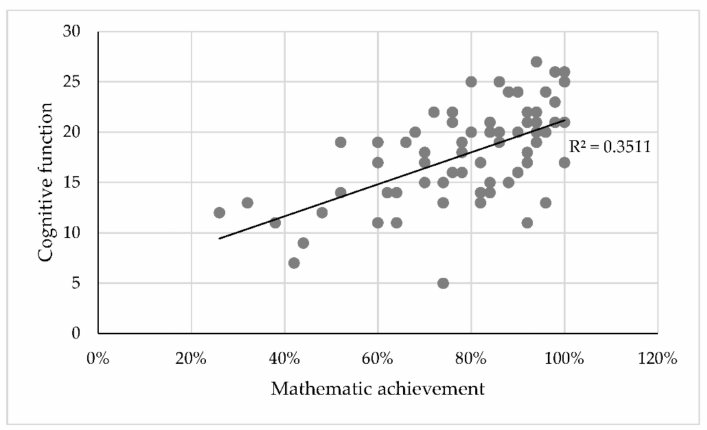
Figure 2. Relationship between mathematics achievement and cognitive